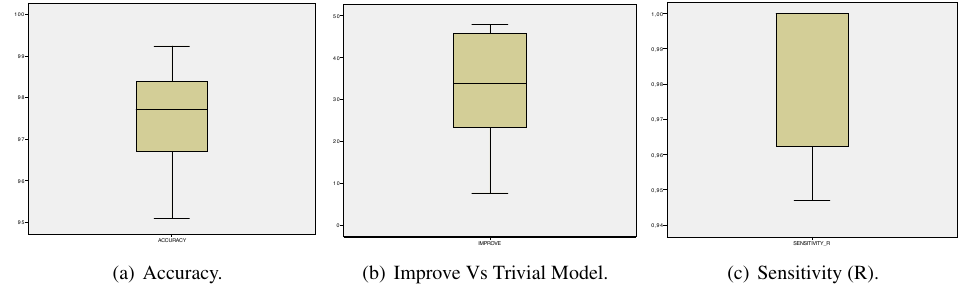
Fig. 4. Boxplots of accuracy, improvement over trivial model and sensitivity